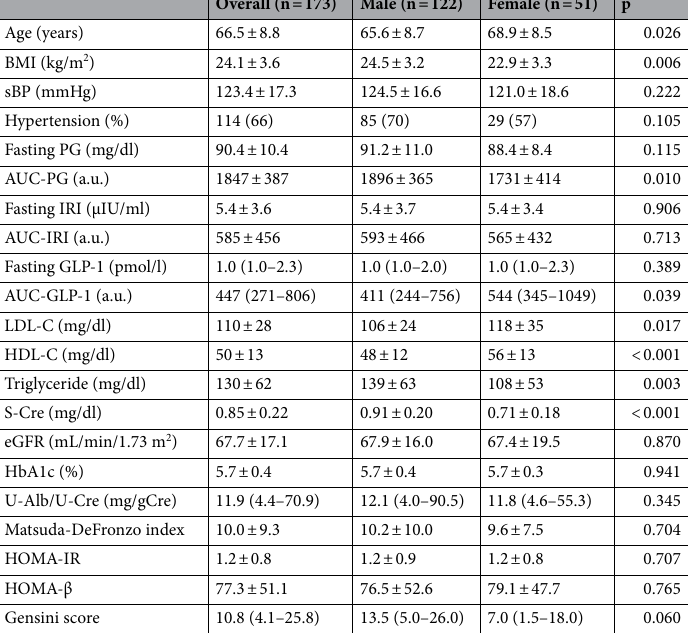
Table 1. Baseline characteristics of patients. sBP: systolic blood pressure; BMI: body mass index; PG: plasma glucose; IRI: immunoreactive insulin; LDL-C: LDL cholesterol; HDL-C: HDL cholesterol; S-Cre: serum creatinine; eGFR: estimated glomerular filtration rate; HbA1c: hemoglobin A1c; U-Alb/U-Cre: ratio of urinary albumin to urinary creatinine. Data are means ± SD or medians (interquartile